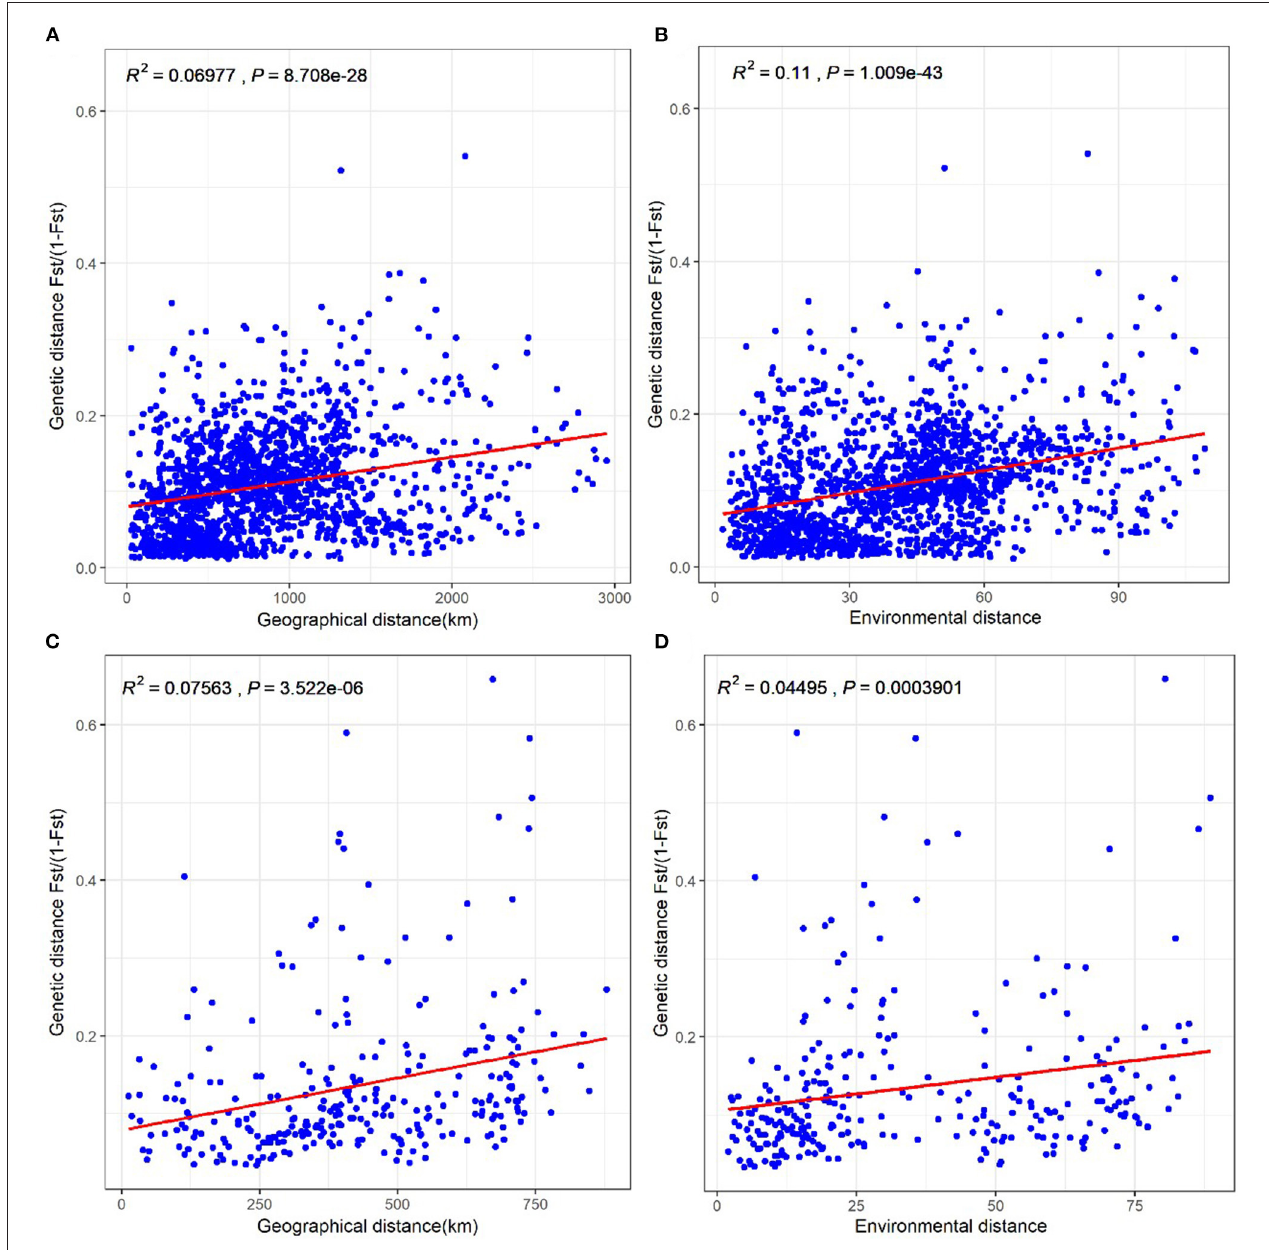
FIGURE 5 | Tests of isolation-by-distance and isolation-by-environment among 58 P. euphratica populations (A,B) and 24 P. pruinosa populations (C,D) , respectively. Correlation coefficients were analyzed with data matrixes of genetic distance × geographical distance and genetic distance × environmental distance from pairwise